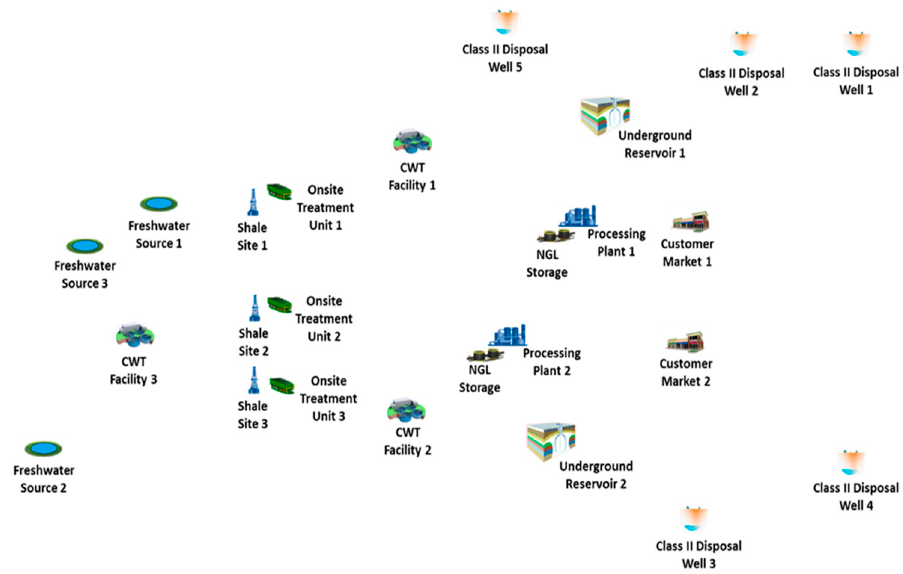
Figure 3. Shale gas network superstructure for optimization problem resolution.